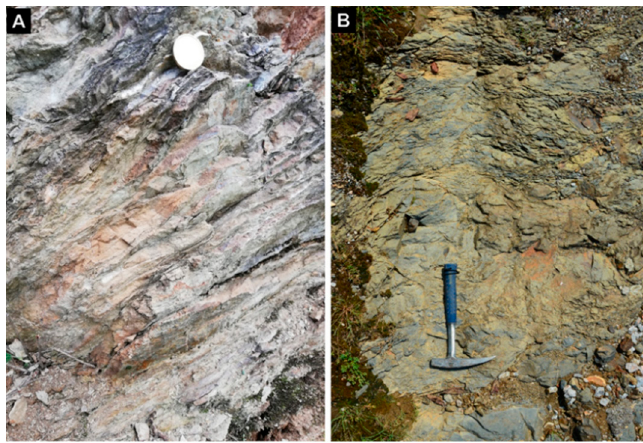
Figure 9. Types of Jurassic flysch metasediments in the Meliata Unit: ( A ) calciclastic flysch at Jaklovce village (0.5 m photo width); and ( B ) siliciclastic flysch composed of dark cherty schists with radiolarites at Meliata village.